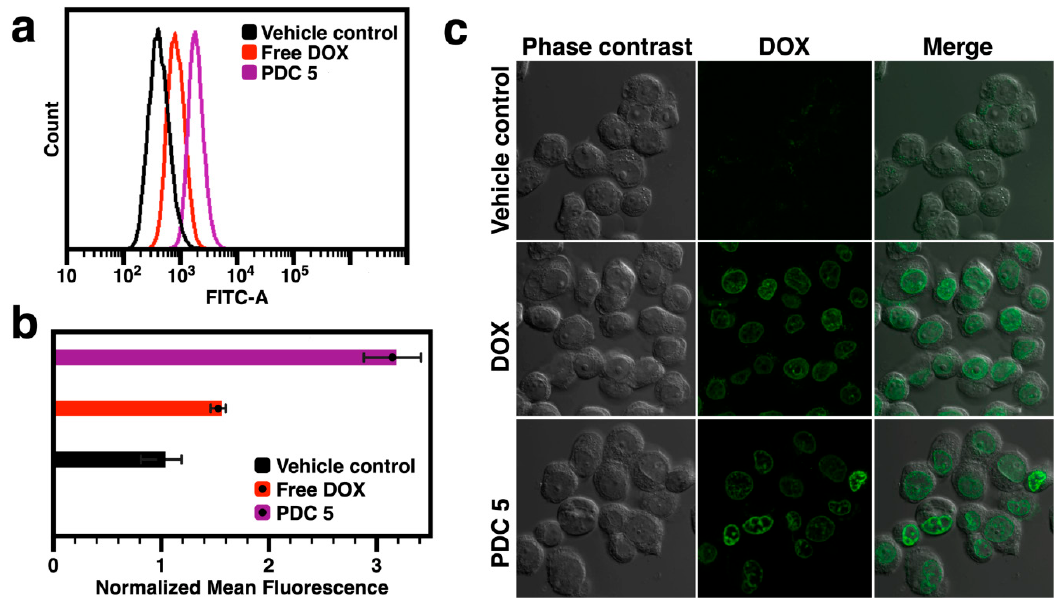
Figure 9. ( a ) A typical flow cytometry data set showing cellular uptake of free DOX and PDC 5 by MCF-7 cells after 24 h incubation; ( b ) mean fluorescence intensity of DOX obtained from flow cytometry. For each data point, the error bar represents standard deviation resulting from three independent experiments; ( c ) confocal microscopy images of MCF-7 cells after 24 h incubation with DOX and PDC 5 .